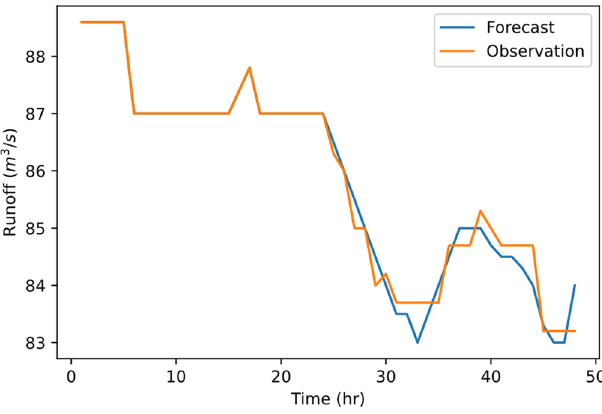
Figure 8. Input/output lines for a streamflow data sequence of 48 h.